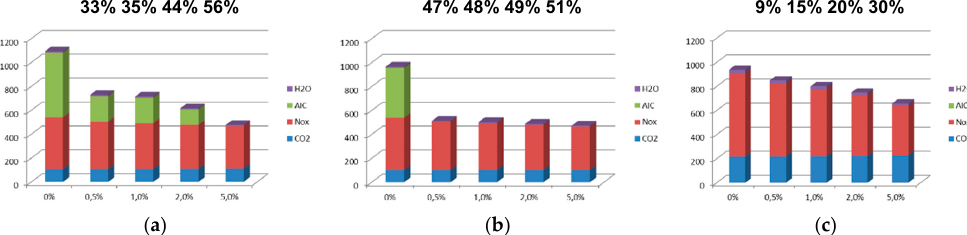
Figure 3. Individual contributions to total climate impact (ATR 20, pK) on Lulea–Gran Canaria ( a ), Helsinki–Gran Canaria ( b ), Baku–Luxembourg ( c ); shown for individual mitigation trajectories allowing fuel increase by 0.5%, 1%, 2% and 5% and fuel optimal (0%). Numbers on top indicating decrease of total climate impact for respective alternative trajectory.